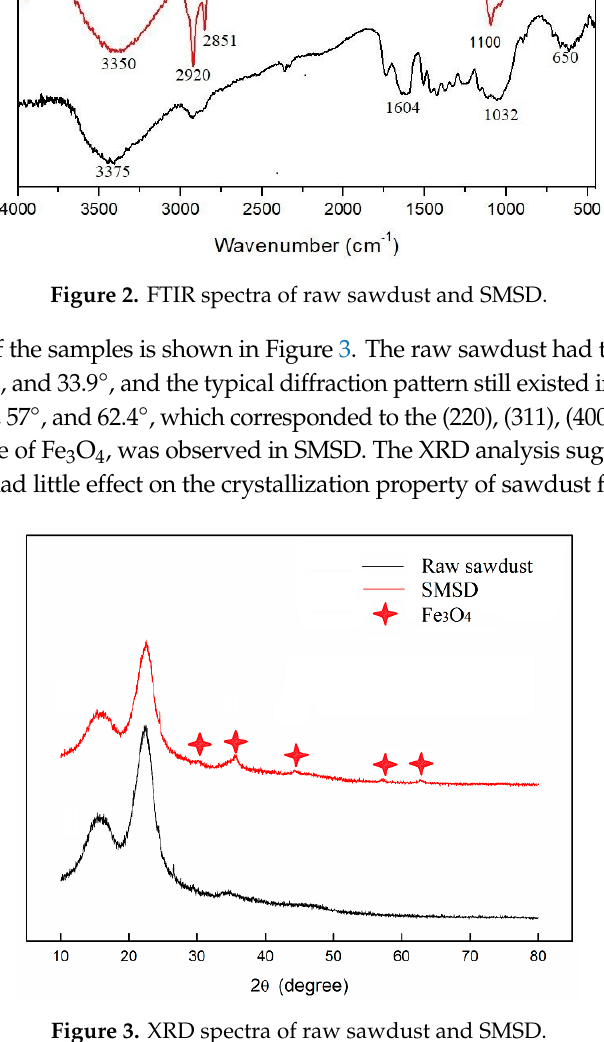
Figure 3. XRD spectra of raw sawdust and SMSD.